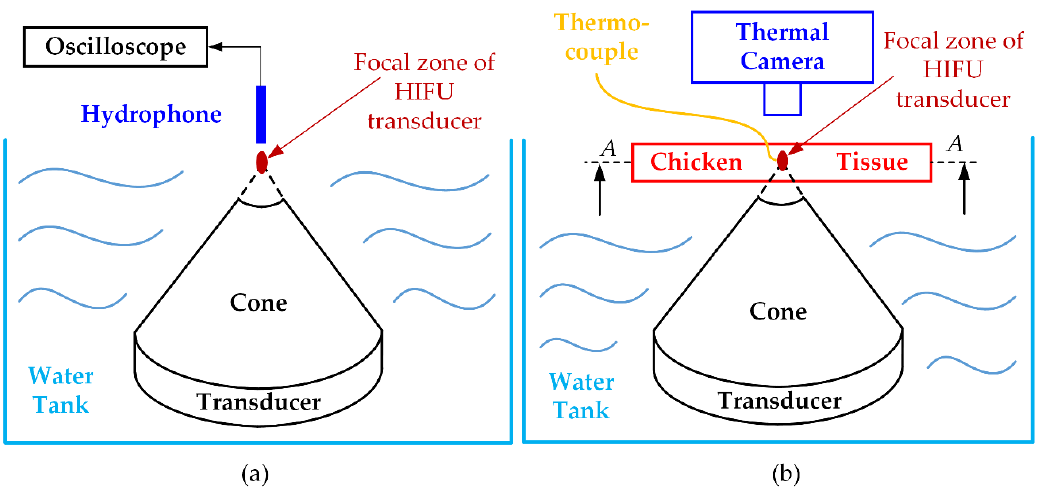
Figure 3. Ex vivo experiment for validating HIFU system performance: ( a ) acoustic pressure measurement ( b ) maximum temperature achievement and fuzzy logic controller testing.